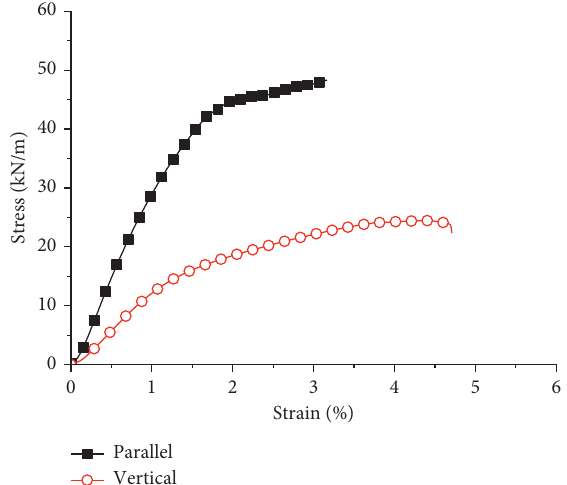
Figure 7: Tensile stress-strain curves of the square